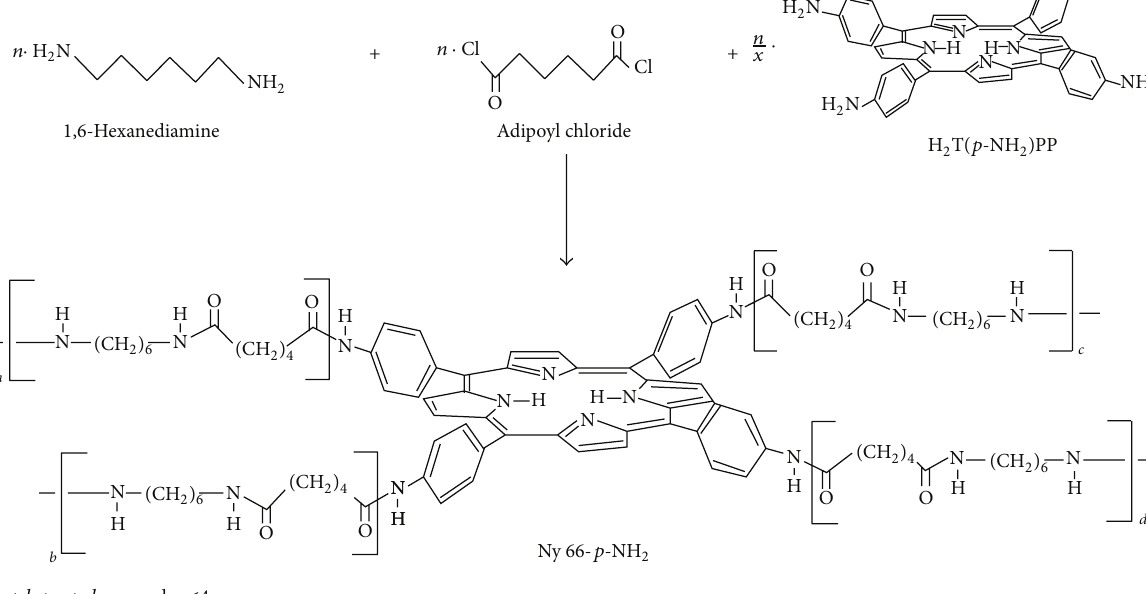
200 to 800 nm (UV-vis) and from 1000 nm to 2500 nm −1 ) (NIR). Infrared spectra (FTIR) (100,000 to 4,000 cm